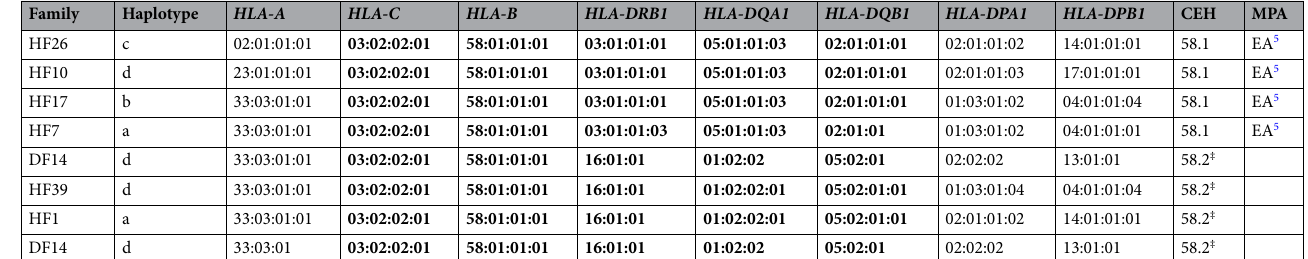
Table 10. MHC haplotypes of UAE families marked by HLA-B*58:01 . The group of alleles that make up the designated CEH in column “CEH” are denoted in bold. CEH: conserved extended haplotypes; MPA: Most probable Ancestry; EA: East Asia; ‡ Proposed